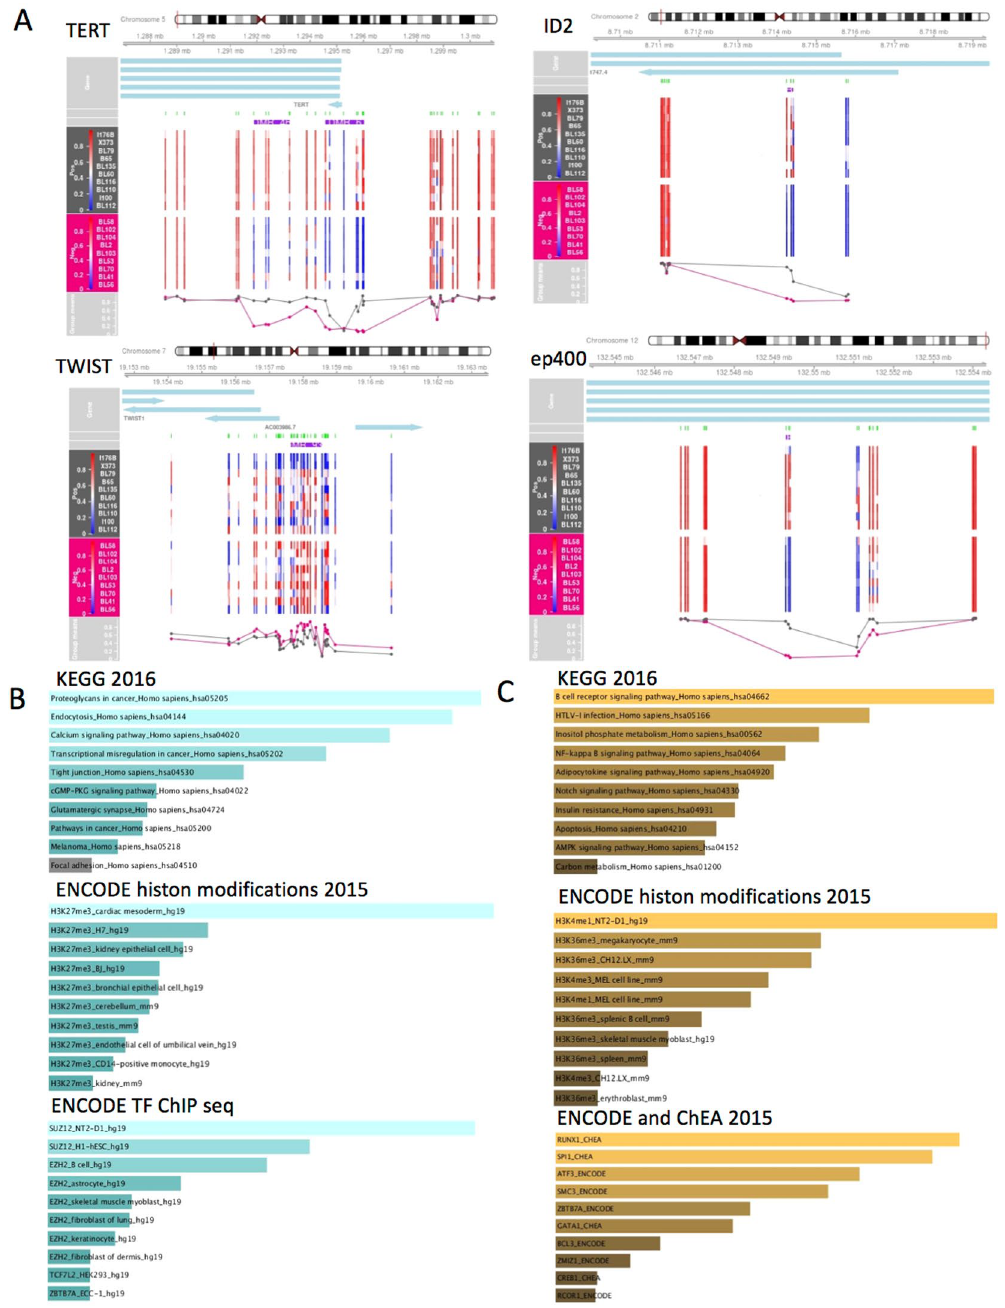
Figure 3. EBV-dependent methylation at the regional level and analysis of pathways targeted by EBV- dependent hyper or hypo methylation. ( A ) DMR plot corresponding to 4 of the EBV-associated DMRs. ( B , C ) Pathway analyses of EBV-associated DMRs discriminated by hypo ( B ) or hypermethylation ( C ). Enrichr web tool was used with the genomic locations of significant DMRs. Enrichment results are shown for the indicated databases (KEGG, BioCarta and ENCODE TF